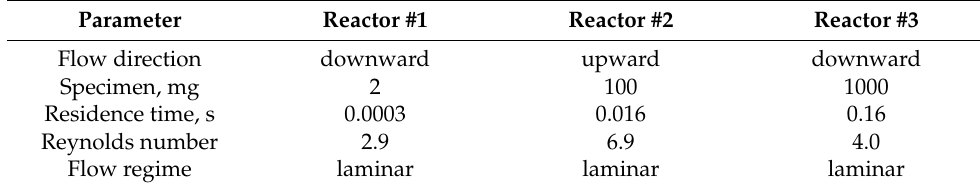
Table 2. Process parameters for the considered reactor types. Parameter Reactor #1 Reactor #2 Reactor #3 Flow direction downward upward downward Specimen, mg 2 100 1000 Residence time, s 0.0003 Reynolds